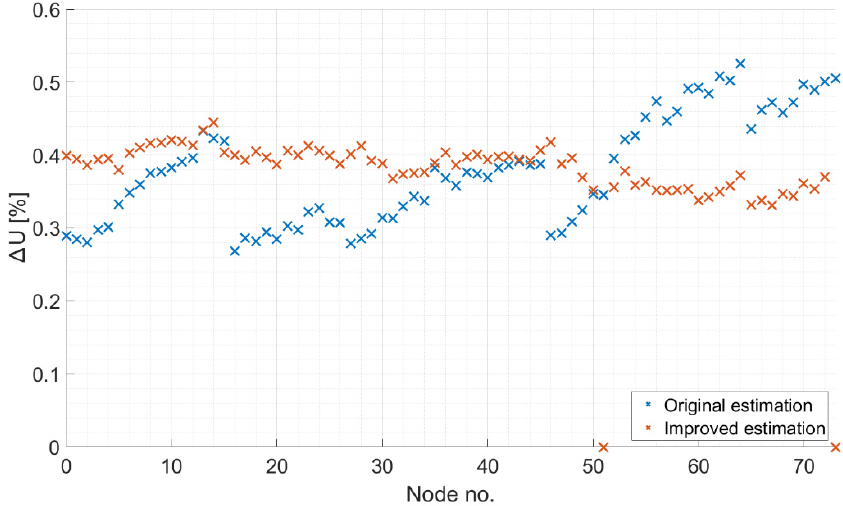
Figure 7. Average relative error of voltages for Area 44,333.